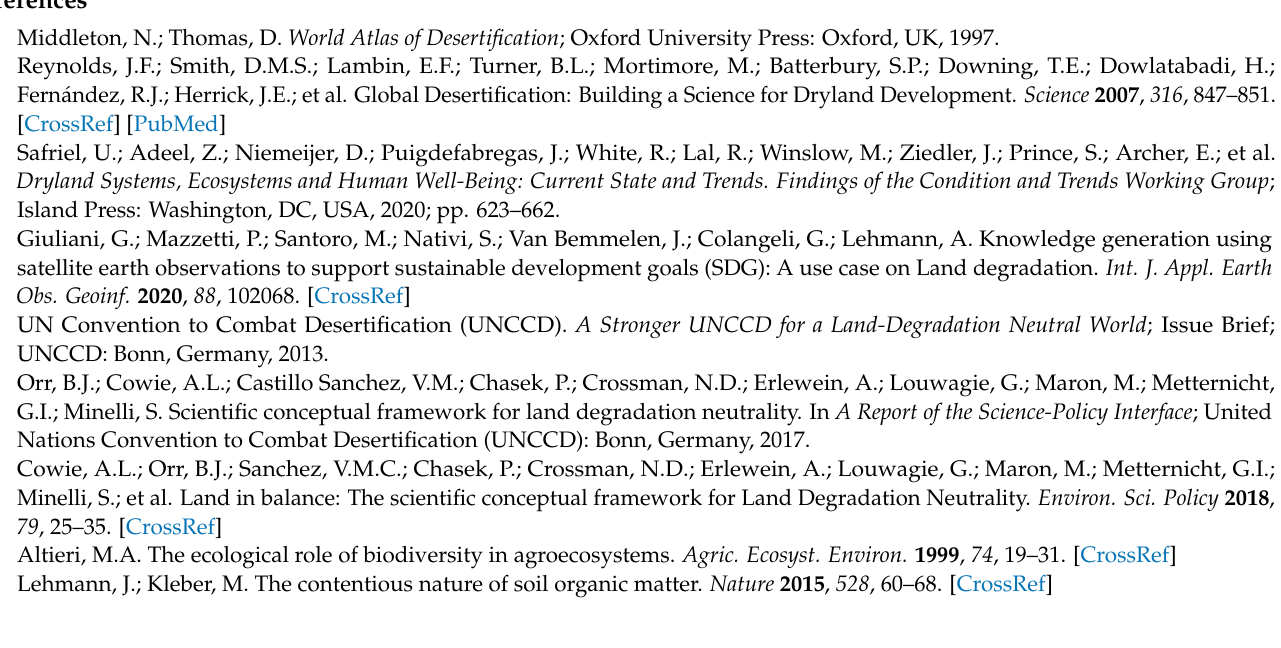
Figure S5: The histograms of estimation uncertainty of XWT-based framework using RR, LS-SVM, RF and GBRT; Figure S6: Average SOM estimated and mapped after 20 operations, using covariate conventionally averaged from endmembers time series; Figure S7: Estimation uncertainties of covariate conventionally averaged from endmembers time